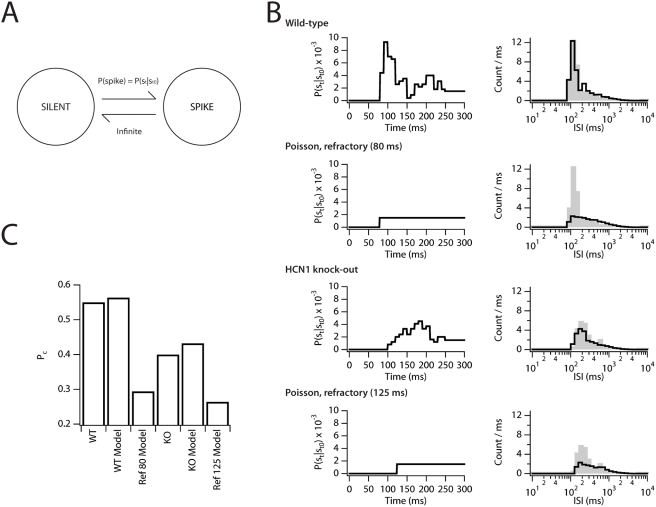
A transient increase in firing probability during recovery from the
AHP is sufficient to account for clustered spiking.Spiking was modeled as a stochastic point process. (A) According to the
point process model the stellate neuron makes stochastic transitions
between a silent and spiking state with a probability determined by
P(st|st0) and an instantaneous transition from
spiking back to silence (see text for explanation). (B) We
considered 4 possible P(st|st0) functions (left
panels). The “Wild-type” and
“Knockout” P(st|st0) curves
are taken directly from data obtained with the corresponding stochastic
models. In addition, Poisson processes with refractory periods of 80 and
125 ms were considered. ISI histograms were generated from long
simulations (1000 s) (right panels). For comparison an ISI distribution
from the wild-type stochastic stellate model is also plotted (gray
bars). (C) For each of the spike trains simulated with the stochastic
point-process model (“WT model” and “KO
model”) Pc was calculated and plotted along with
the Pc values in the 1–2 Hz bin of simulations in
the wild-type (“WT”) and knockout
(“KO”) versions of the stochastic stellate
model.